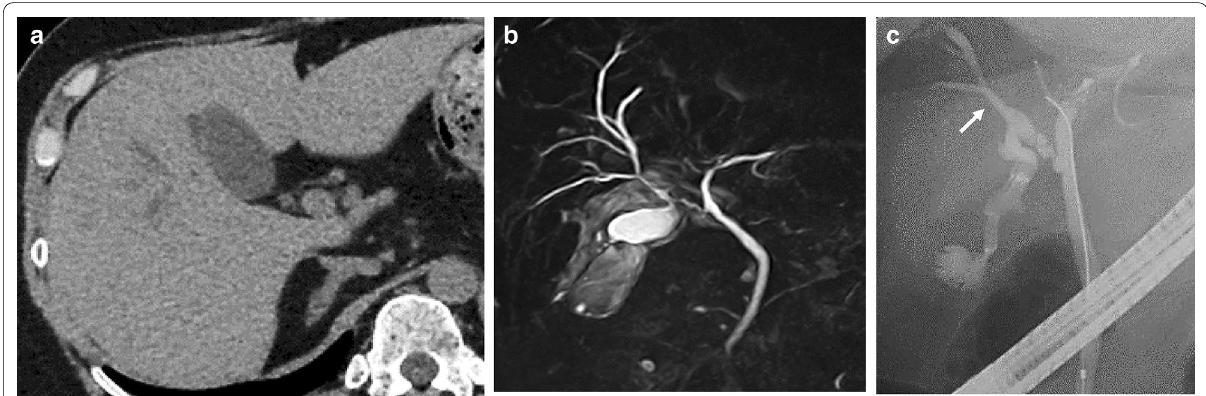
Fig. 1 Preoperative imaging of the anomalous cystic duct. a Plain abdominal computed-tomography revealing a dilated right hepatic duct. b Magnetic resonance cholangiopancreatography showing the congenital anomaly of the right hepatic duct entering the cystic duct. c Endoscopic retrograde cholangiopancreatography confirmed the right hepatic duct entering the cystic duct. An arrow indicates right hepatic duct